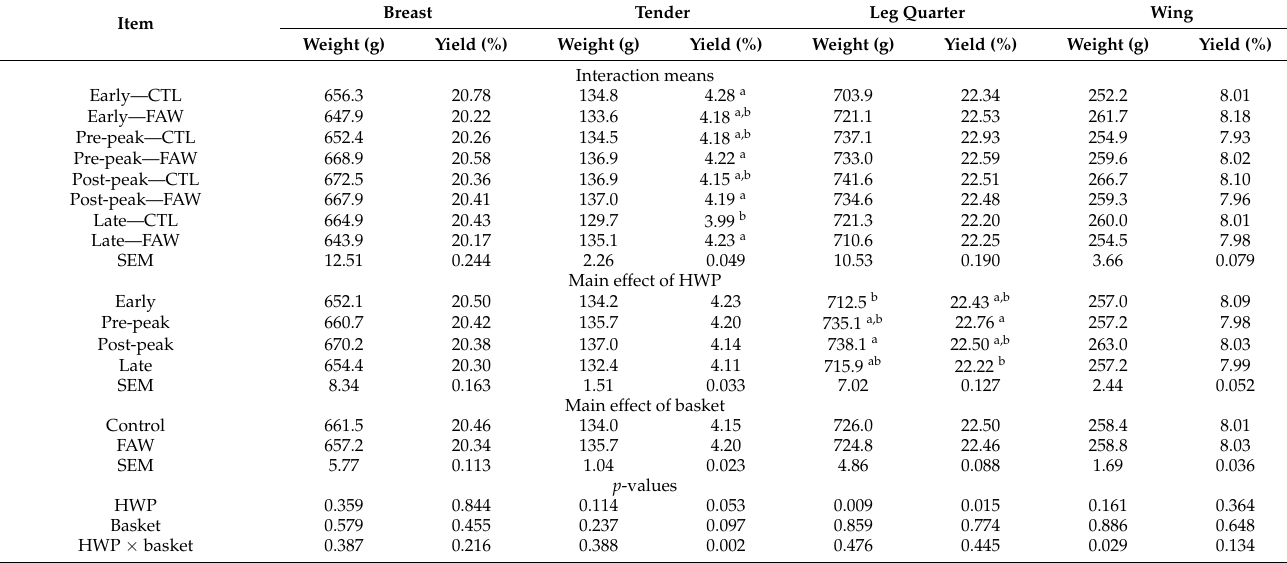
Table 7. Processing weight and yield of broilers from different hatch window periods (HWP) within a single hatch window provided feed and water (FAW) in the hatch basket compared to a control (CTL) 1